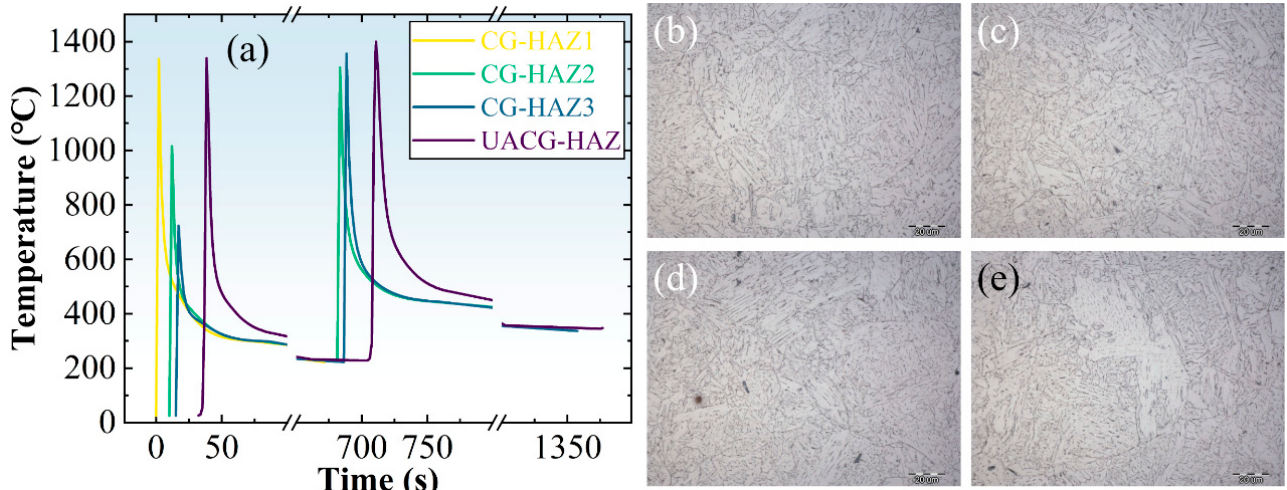
Figure 10. Thermal processes in zones with CG-HAZ processes during the last austenitized cycles and the thermal simulated microstructures (with a magnification of 1000): ( a ) thermal cycles calculated for thermal simulation in CG-HAZs; ( b ) CG-HAZ1; ( c ) CG-HAZ2; ( d ) CG-HAZ3; ( e ) UACG-HAZ.